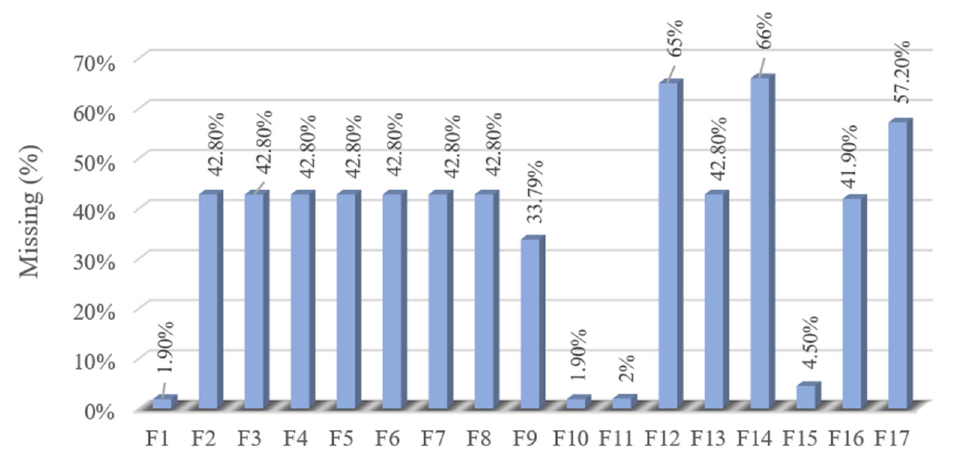
Figure 3. The MNAR pattern analysis of the IRDia dataset.